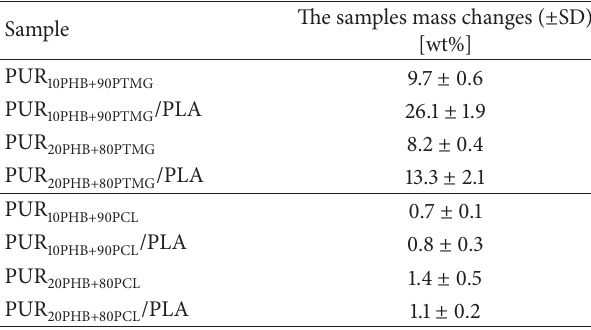
Table 2: The oil sorption by polyurethanes and their blends.